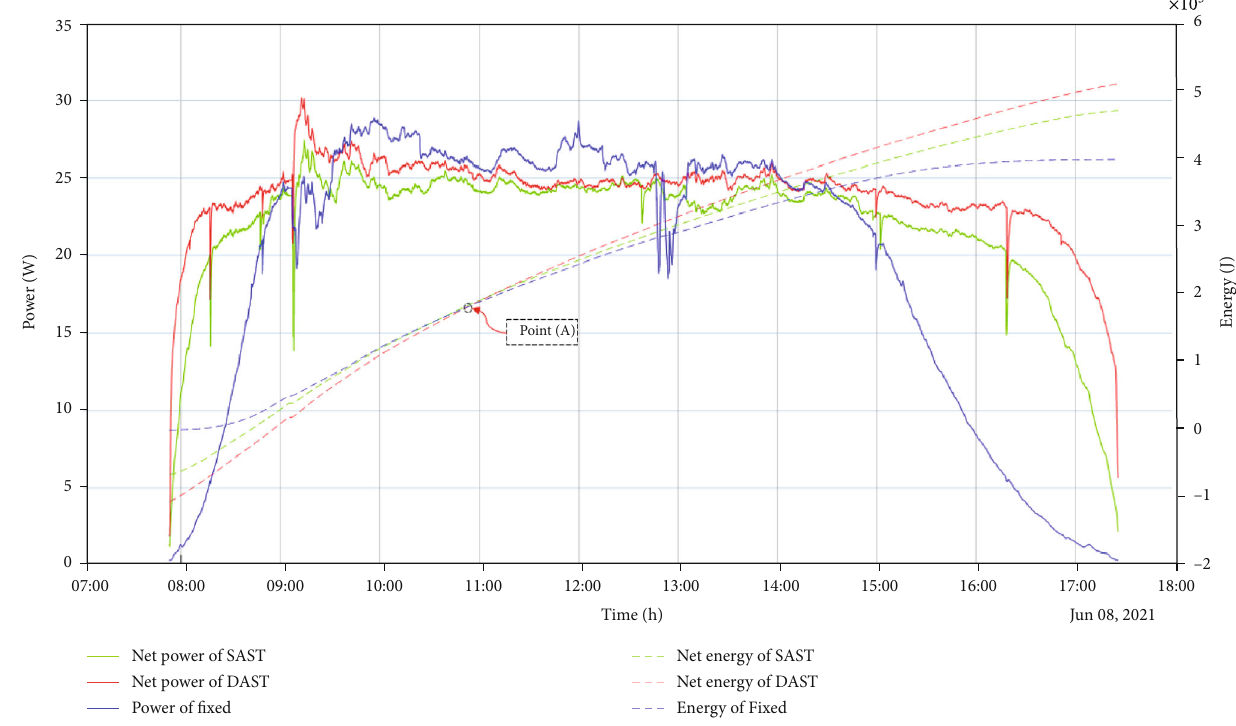
Figure 13: Net power and energy of SAST, DAST, and